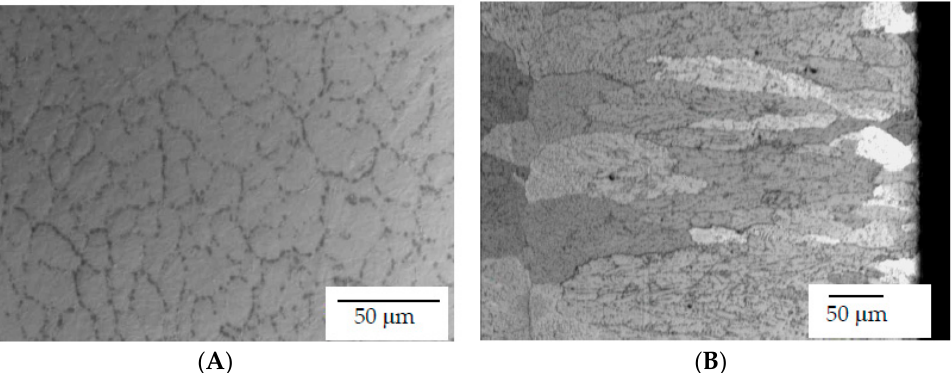
Figure 7. ( A ) Microstructure of the Ti6Al4V of a Zimmer dental implant. ( B ) Microstructure of the Ti6Al4V of a BioHorizons dental implant with laser treatment.